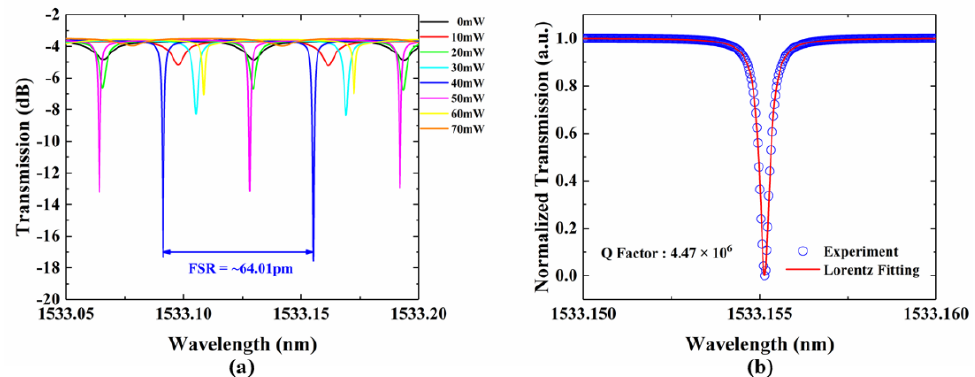
Figure 5. ( a ) Coupling-condition tuning of tunable MRR; ( b ) deepest resonant peak with Lorentzian fitting.